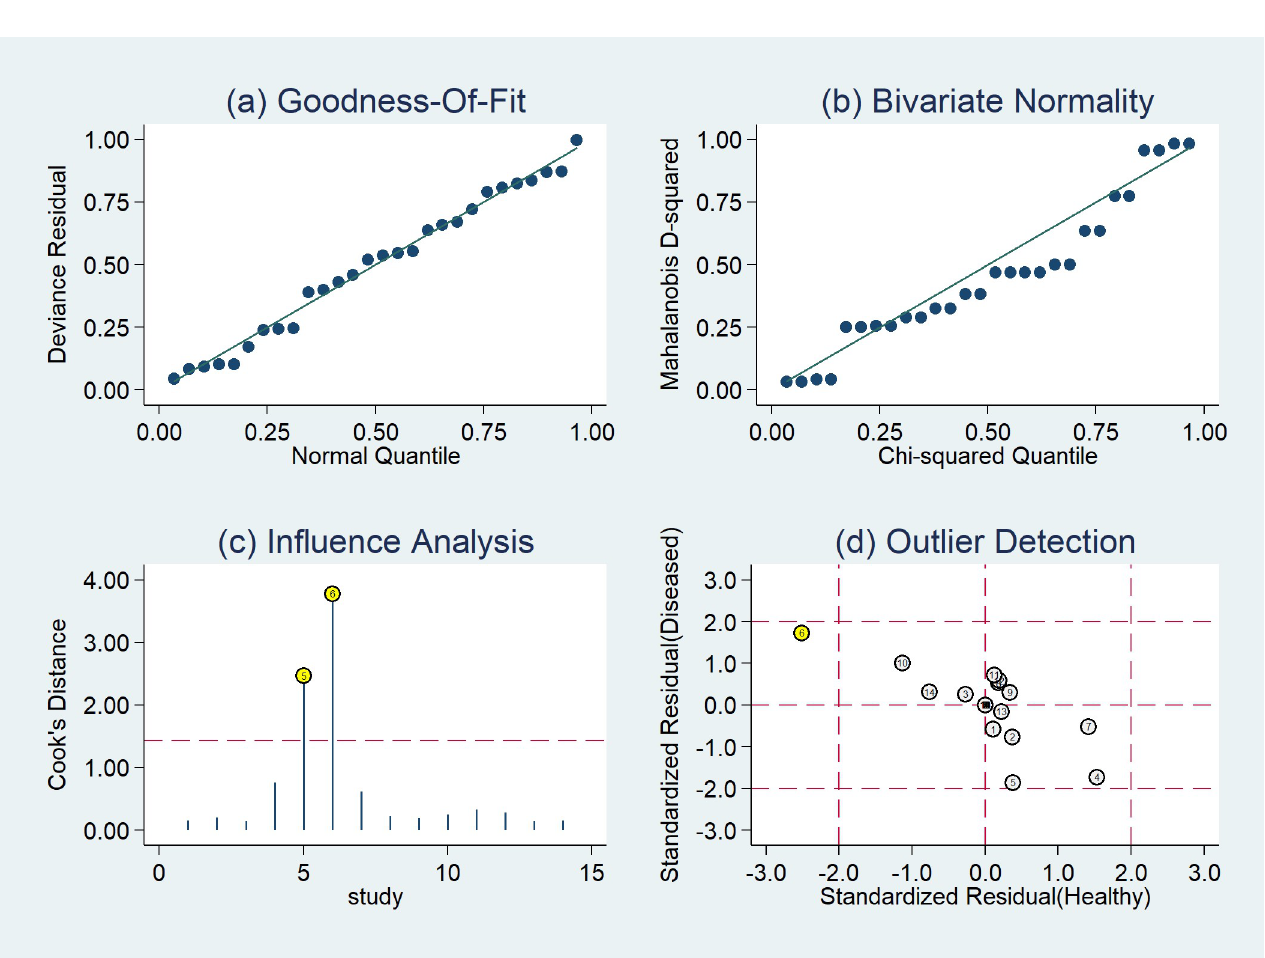
Fig 6. The results of sensitivity analysis (a: Goodness of fit. b: Bivariate normality. c: Influence analysis. d: Outlier detection).